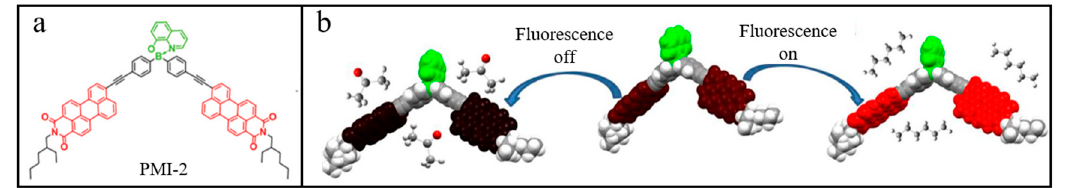
Figure 11. ( a ). Molecular structure of PMI-2; ( b ). Schematic diagram for the process of capillary condensation and solvation Figure 11. ( a ) Molecular structure of PMI-2; ( b ) Schematic diagram for the process of capillary condensation and solvation effect enabling absorption of vapor analytes within the film of PMI-2 [74]. effect enabling absorption of vapor analytes within the film of PMI-2